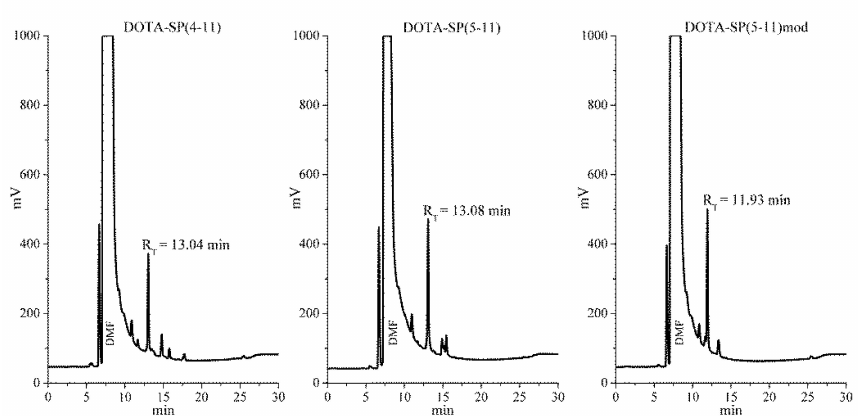
Figure 9. HPLC chromatograms (system 1) of reaction mixtures of DOTA-SP(4–11),